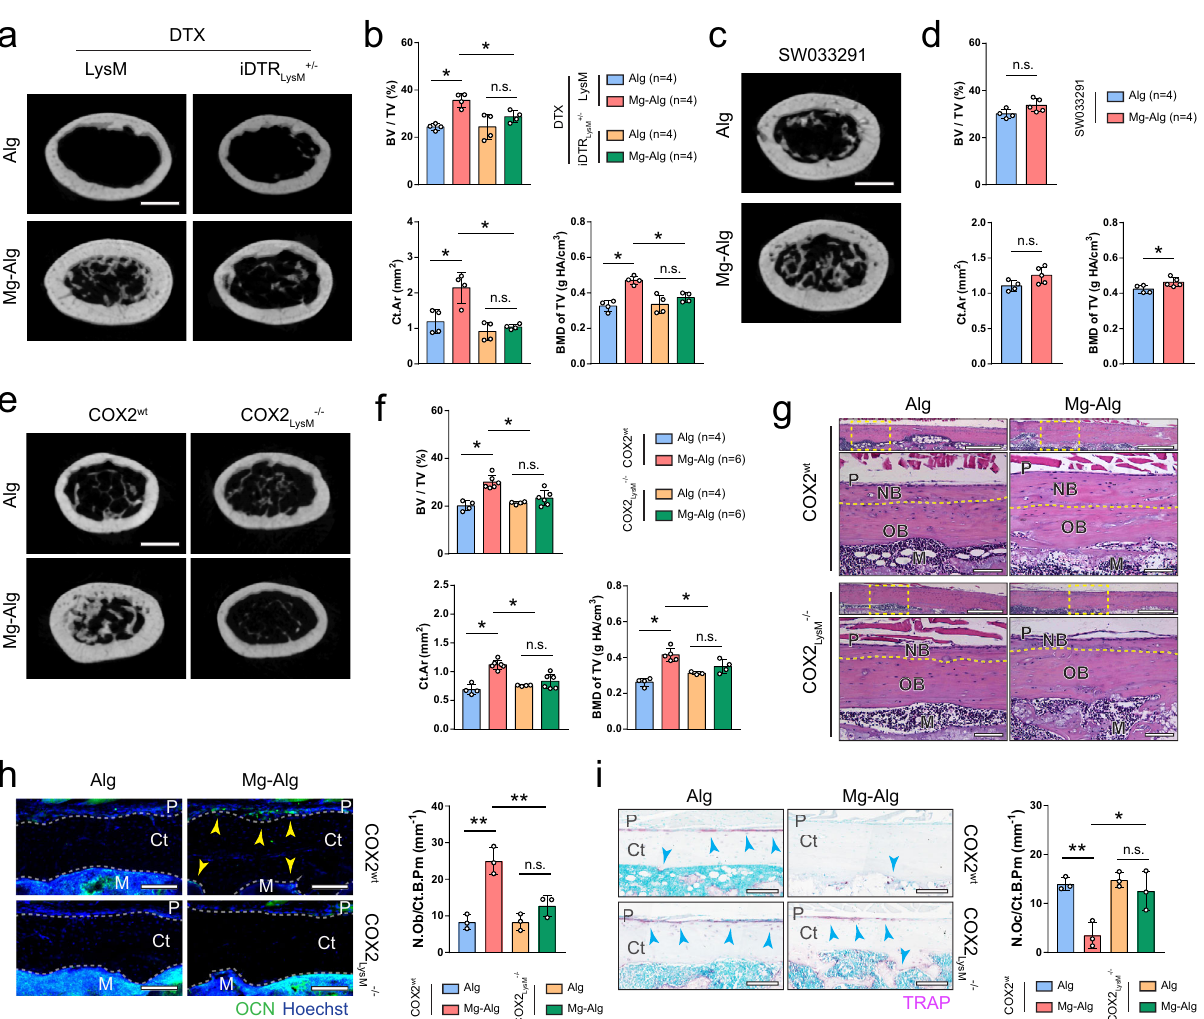
Fig. 3 Macrophage-derived PGE 2 mediates divalent cation-induced bone formation. Reconstructed µ CT images ( a , scale bars = 1 mm) showing the cross-section of LysM or iDTR LysM + / − mouse femurs after the administration of diphtheria toxin and corresponding measurements ( b ) of BV/TV, BMD of TV, and Ct.Ar. Reconstructed µ CT images ( c , scale bars = 1 mm) showing the cross-section of mouse femurs after the administration of SW033291 and corresponding measurements ( d ) of BV/TV, BMD of TV, and Ct.Ar. Reconstructed µ CT images ( e , scale bars = 1 mm) showing the cross-section of femurs from COX2 wt mice or COX2 LysM − / − mice grafted with pure alginate or Mg 2 + -releasing alginate, as well as corresponding measurements ( f ) of BV/ TV, BMD of TV, and Ct.Ar. g Representative H&E staining images showing the periosteal new bone formation in COX2 wt or COX2 LysM − / − mice ( n = 3). Lower images (scale bars = 100 µ m) are high-resolution versions of the boxed regions in the upper images (scale bars = 500 µ m). h Representative immuno fl uorescent images and corresponding quanti fi cation showing the presence of OCN + osteoblasts on the cortical bone surface (scale bars = 100 µ m, n = 3). i Representative TRAP staining images and corresponding quanti fi cation showing the presence of TRAP + osteoclasts on the cortical bone surface (scale bars = 100 µ m, n = 3). Data are mean ± s.d., * P < 0.05, ** P < 0.01 by one-way ANOVA with Tukey ’ s post hoc test ( b , f , h , i ) or Student ’ s two- sided T-test ( d ). Source data are provided as a source data fi fi bers in the bone marrow cavity and the endocortical and peri- osteal surfaces of TrkA wt mice 7 days after surgery, whereas the number of CGRP + sensory nerve fi bers in TrkA Avil − / − mice was signi fi cantly lower relative to WT mice (Fig. 4g). Similarly, Mg 2 + stimulated bone formation in TrkA wt mice, and such effects were eliminated in TrkA Avil − / − mice (Fig. 4h, i and Supplementary Fig. 7c). Taken together, divalent cation-induced sensory inner- vation in injured bone tissue is essential for new bone formation.